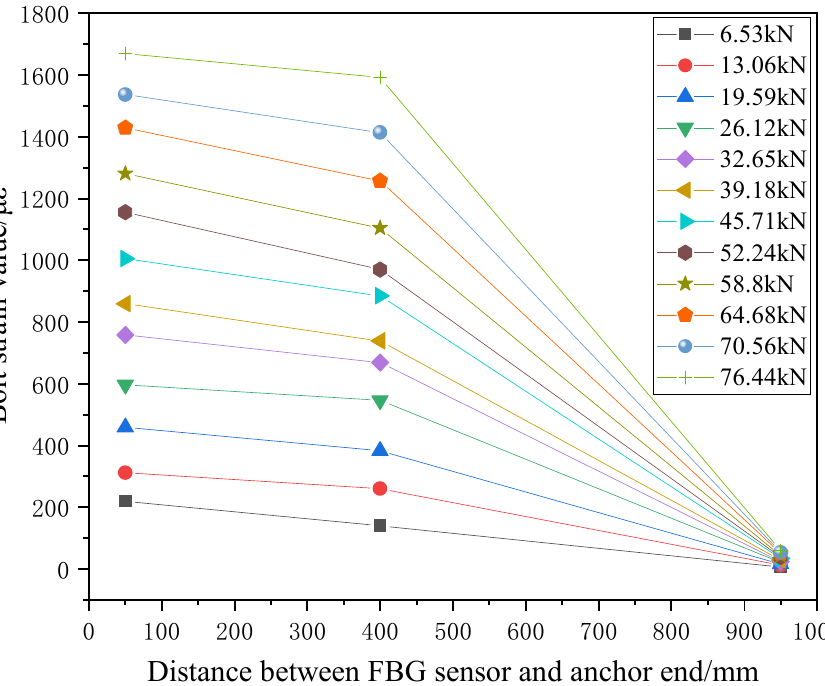
Figure 7. Strain values at different positions of bolt body under different loads.